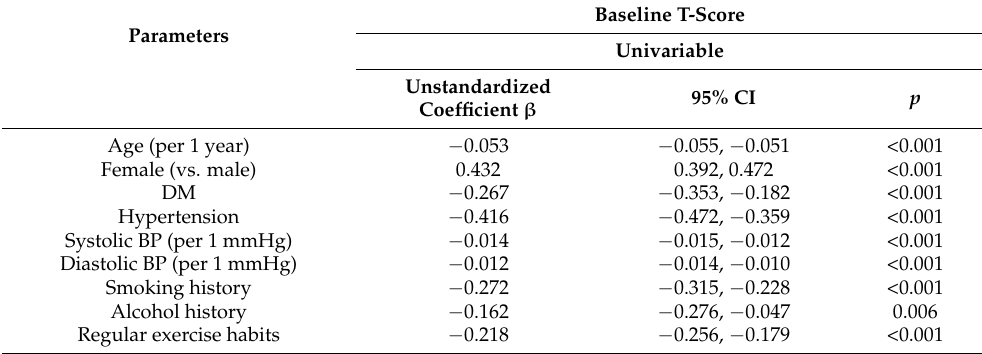
Table 3. Determinants of baseline T-score using univariable linear regression